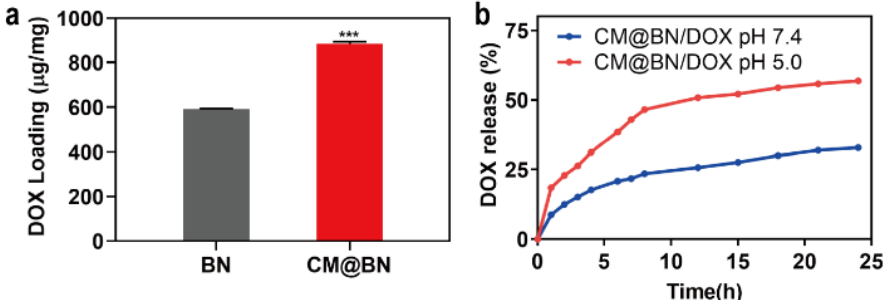
Figure 4. Drug loading and release. ( a ) Amount of doxorubicin (DOX) loaded on BN and CM@BN. ( b ) DOX release from BN/DOX and CM@BN/DOX complexes at different conditions. Data expressed as means ± SD, *** p < 0.001.